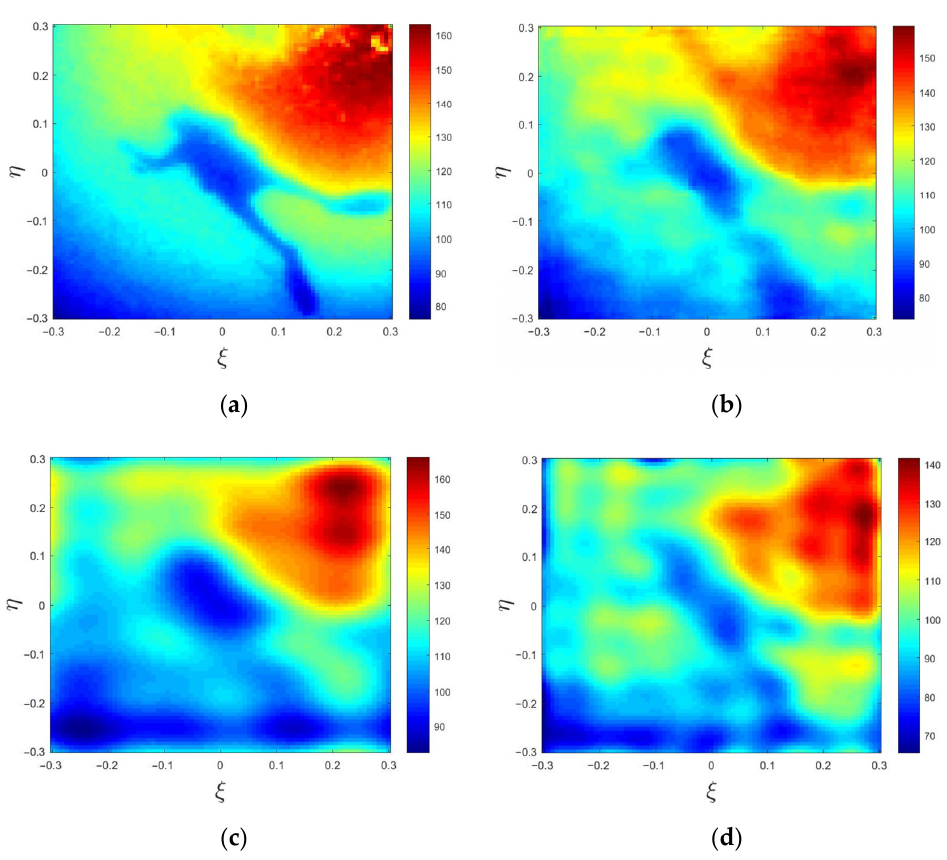
Figure 5. The IASR images reconstructed by different methods at the same scene. ( a ) Original scene. ( b ) IASR-CNN method. ( c ) Grid method. ( d ) AFF method.